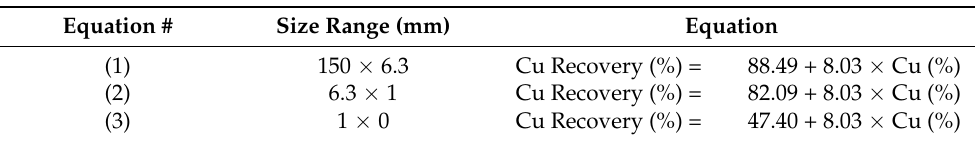
Table 9. Regression model for copper recovery in the rougher stage for groups of sizes as a function of % Cu in the